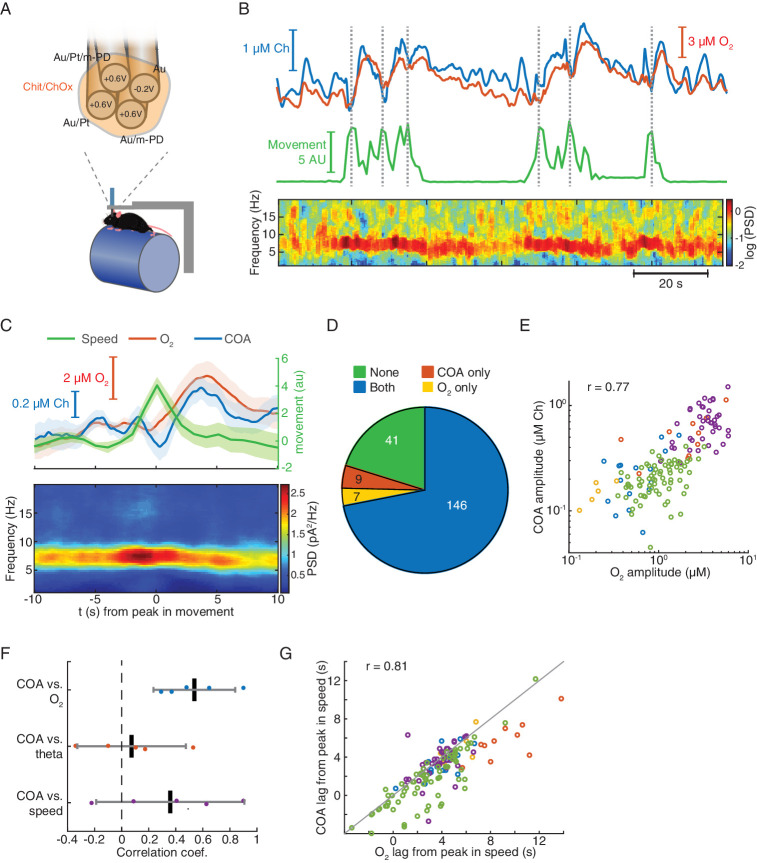
Locomotion-related correlated changes in COA and local oxygen concentration in head-fixed mice.(A) The schematics of the tetrode configuration used to simultaneously measure COA (H2O2) and extracellular O2.in head-fixed mice. Values on each recording site indicate the applied DC voltage vs. Ag/AgCl (+0.6 V for H2O2 and −0.2 V for O2 measurement). (B) Representative segment of simultaneous recording of COA and O2 (top), locomotion speed (middle) and LFP spectrogram (bottom). Dashed lines indicate times of detected locomotion bouts. (C) Average speed, COA and O2 signals (top) and LFP power spectrogram (bottom) triggered on locomotion bouts (n = 41 from one recording session). (D) Event counts across different categories of locomotion bouts, distinguished by the occurrence or absence of COA and/or O2 peaks. Data were collected from five recordings in three mice. (E) Amplitude of COA (shown as calibrated Ch concentrations) vs O2 transients following locomotion bouts (data from the events with increases in both signals, n = 146). Each color represents one recording session (n = 5–74 events per recording). Amplitudes were significantly correlated (rspearman = 0.77, p<0.001). (F) Spearman correlation coefficients between COA amplitudes and O2, theta power or speed (n = 5). Correlation across recordings was significant for ChOx vs O2 data (p<0.01, t-test). Each point represents a single recording session. (G) Peak lags of COA vs. O2 relative to the peak in speed (rspearman = 0.81, p<0.001, n = 146). Colors represent recording sessions (n = 5–74 events per recording). The diagonal line was plotted to ease comparison between lags. Data were obtained from five recordings in three mice and are represented as mean ± CI.